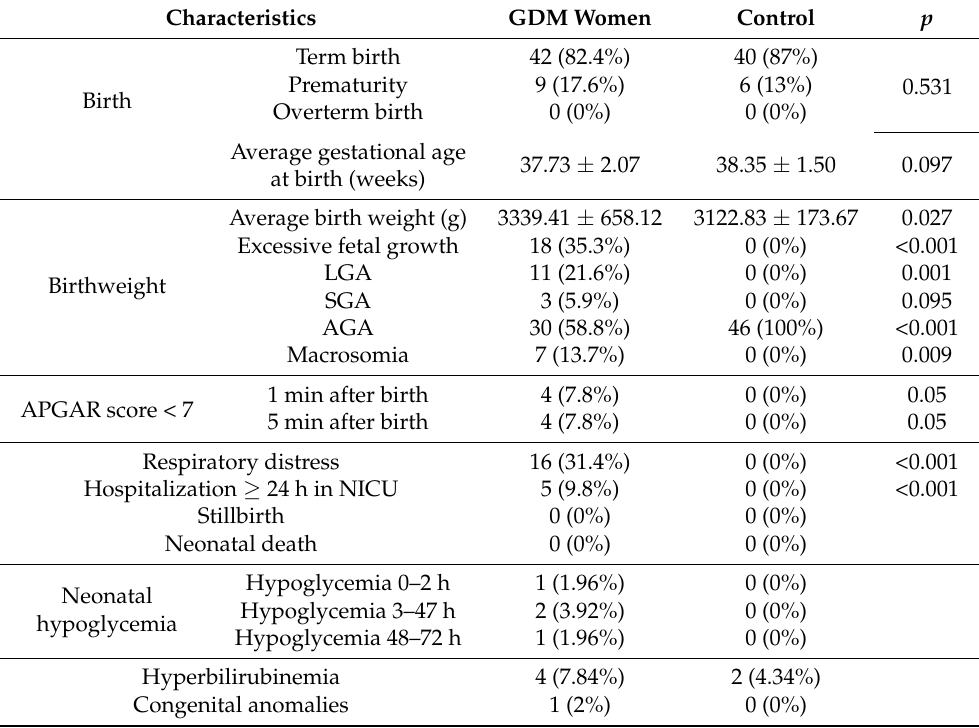
Table 4. Neonatal complications associated with